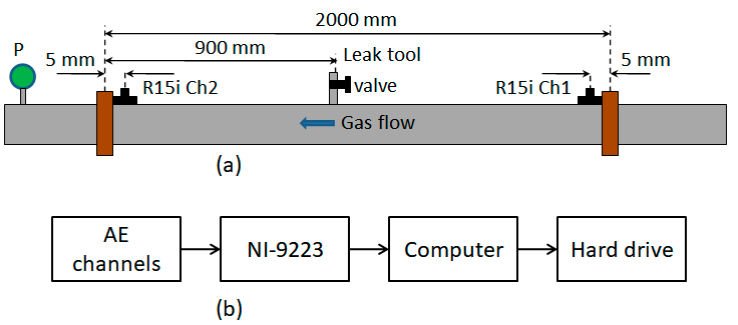
Figure 2. Experimental setup: ( a ) test section, ( b ) data acquisition system. (R15i Ch1 and R15i Ch2 are acoustic emission (AE) channels, P is a pressure meter).